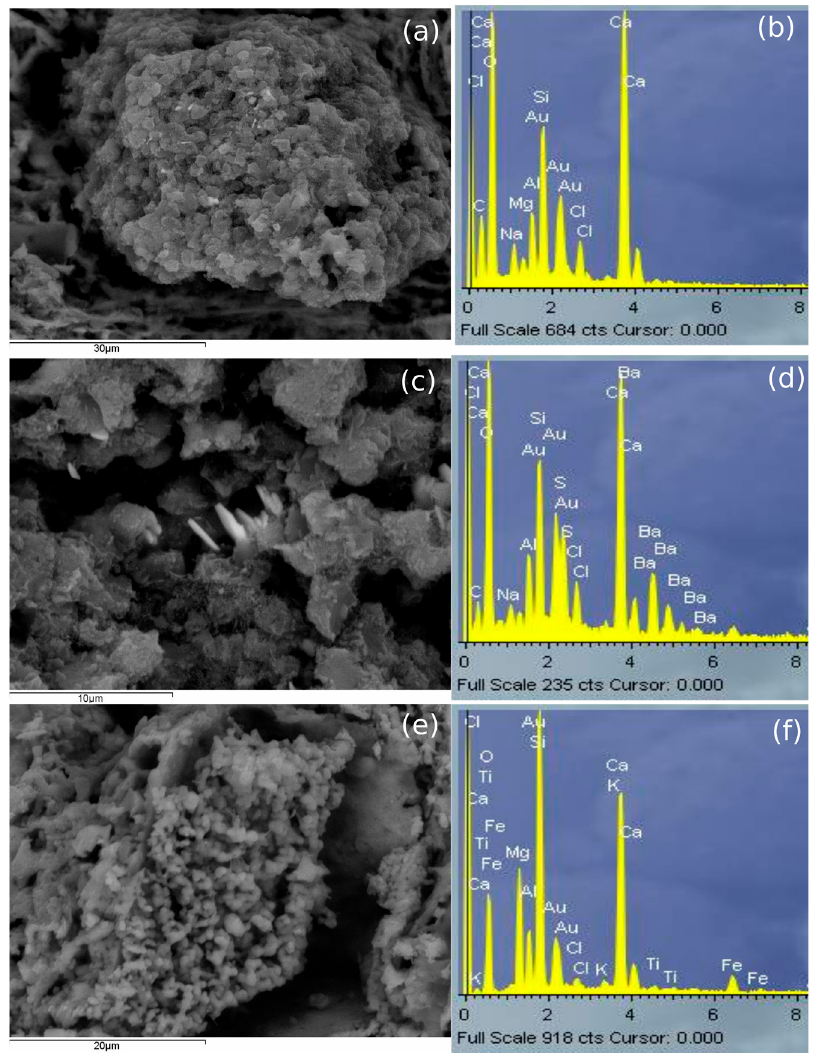
Figure 8. ( a , b ) SEM-BSD image and EDS analysis of an aggregate of PT010 composed mainly of Ca, Mg, O, C, Na and Cl, probably a calcium carbonate and salts; ( c , d ) SEM-BSD image and EDS analysis of an aggregate of PT010, probably barite; ( e , f ) SEM-BSD image and EDS analysis of an aggregate of PT016, probably magnesium and calcium hydroxide or carbonate.